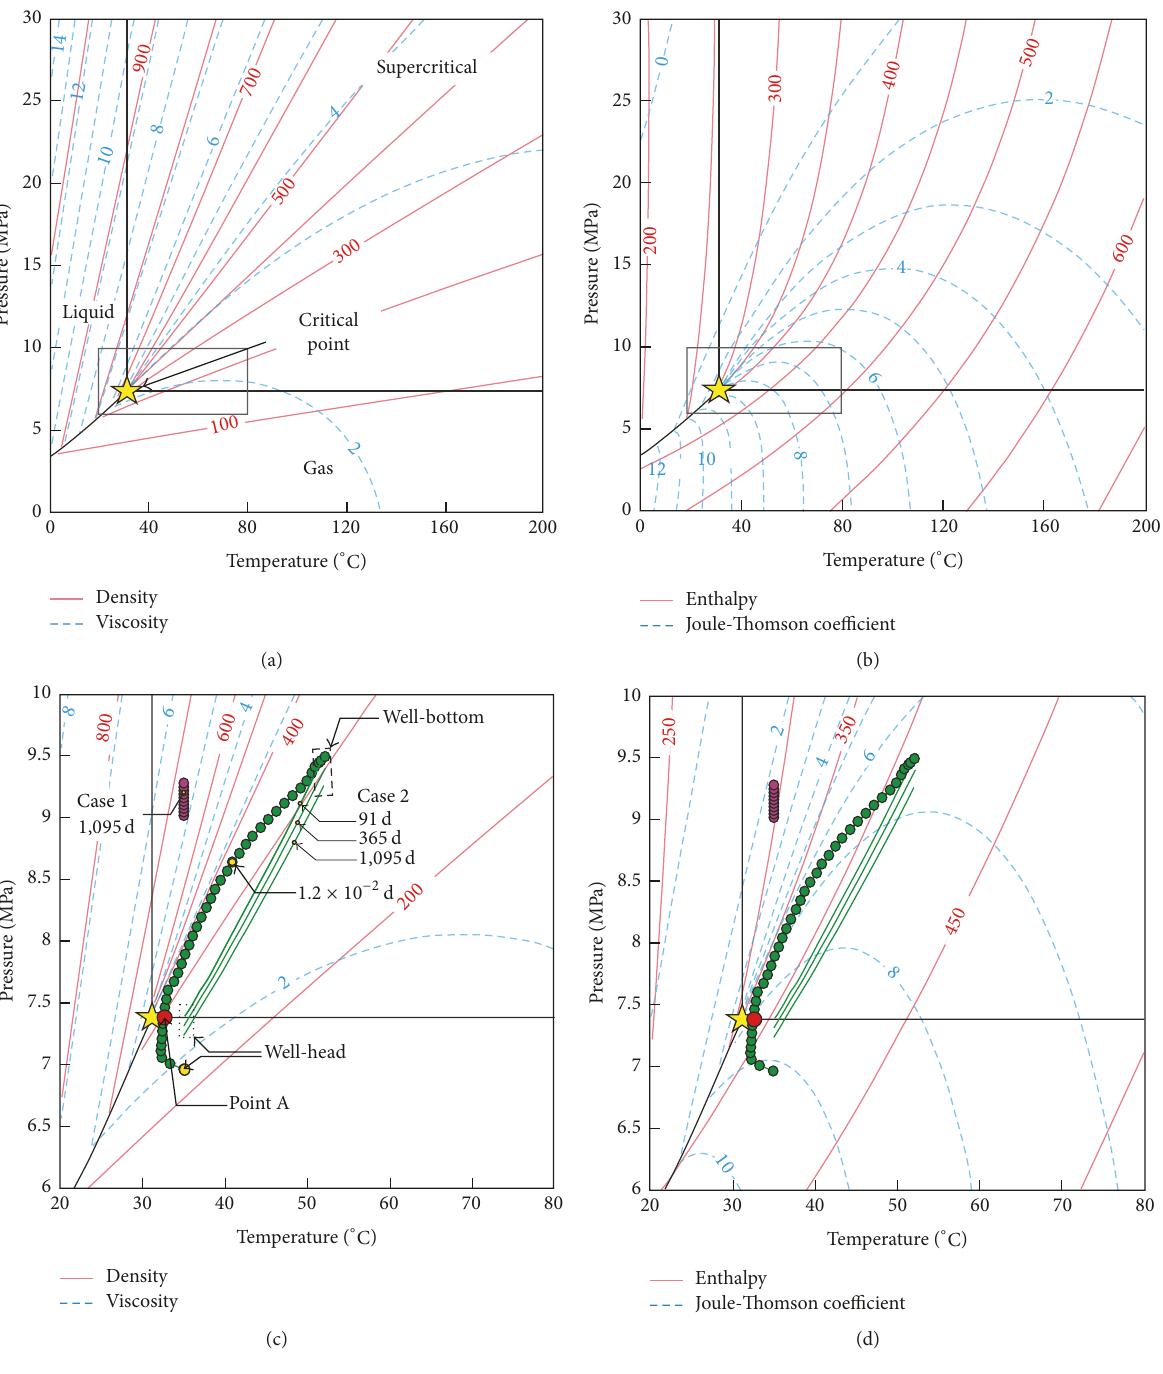
Figure 3: Contours of (a) density [kg/m 3 ] and viscosity [10 −5 Pa ⋅ s] and (b) enthalpy [kJ/kg] and Joule-Thomson coefficient [ ∘ C/MPa] in 𝑃 - 𝑇 space. Gray box represents a suitable condition for the wellbore during geologic CO 2 sequestration ( 𝑃 : 6 to 10MPa and 𝑇 : 20 to 80 ∘ C). (c) and (d) represent contours for density, viscosity, enthalpy, and Joule-Thomson coefficient in 𝑃 - 𝑇 regime suitable for the wellbore. Purple symbols represent the conditions for CO 2 injection in Case 1 . Green symbols and lines represent the conditions for the wellbore in Case 2 .